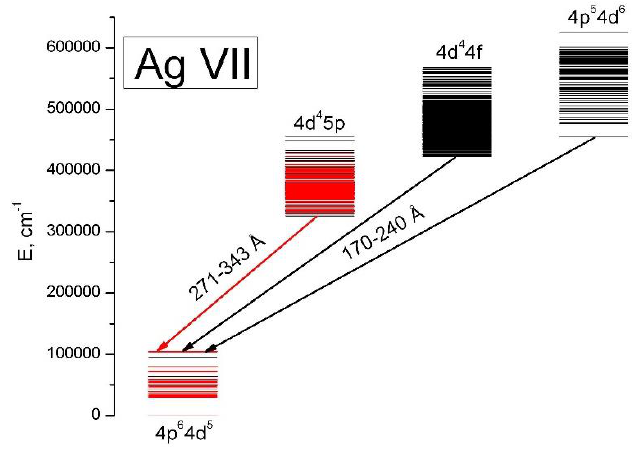
Figure 2. Energy levels of Ag VII. The arrows show electric dipole transitions. The levels found in this work and studied transitions are marked by red color. Black color indicates unknown levels and transitions.